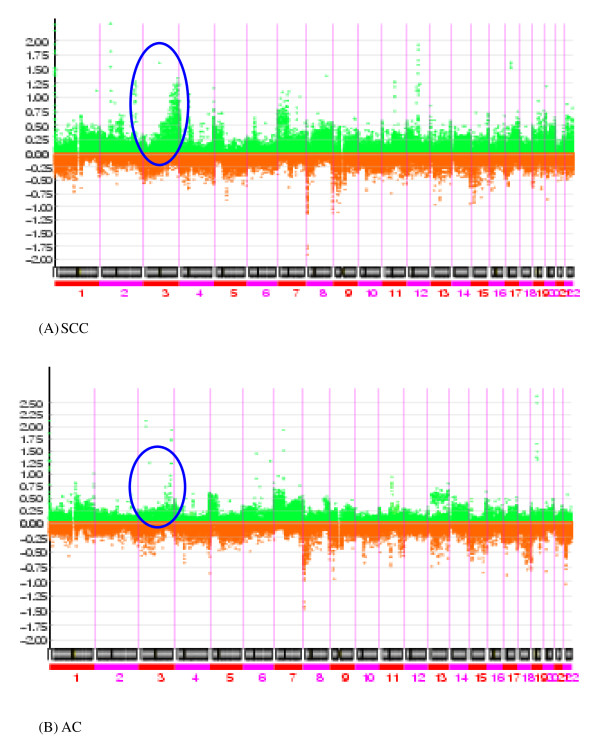
The X-axis represents chromosome number (1 – 22) and the Y-axis represents the genome-wide frequencies of gains (> 0.25 of intensity ratio) and losses (< 0.25 of intensity ratio) for each clone of NSCLC are shown. Vertical lines indicate chromosomal boundaries. (A) Frequencies of genes increased in copy number or decreased in copy number in SCC of the lung. (B) Frequency of gene copy number abnormalities in the AC. Gains and losses are shown as green and red color bars, respectively, which indicate the overall chromosomal copy number aberrations detected.